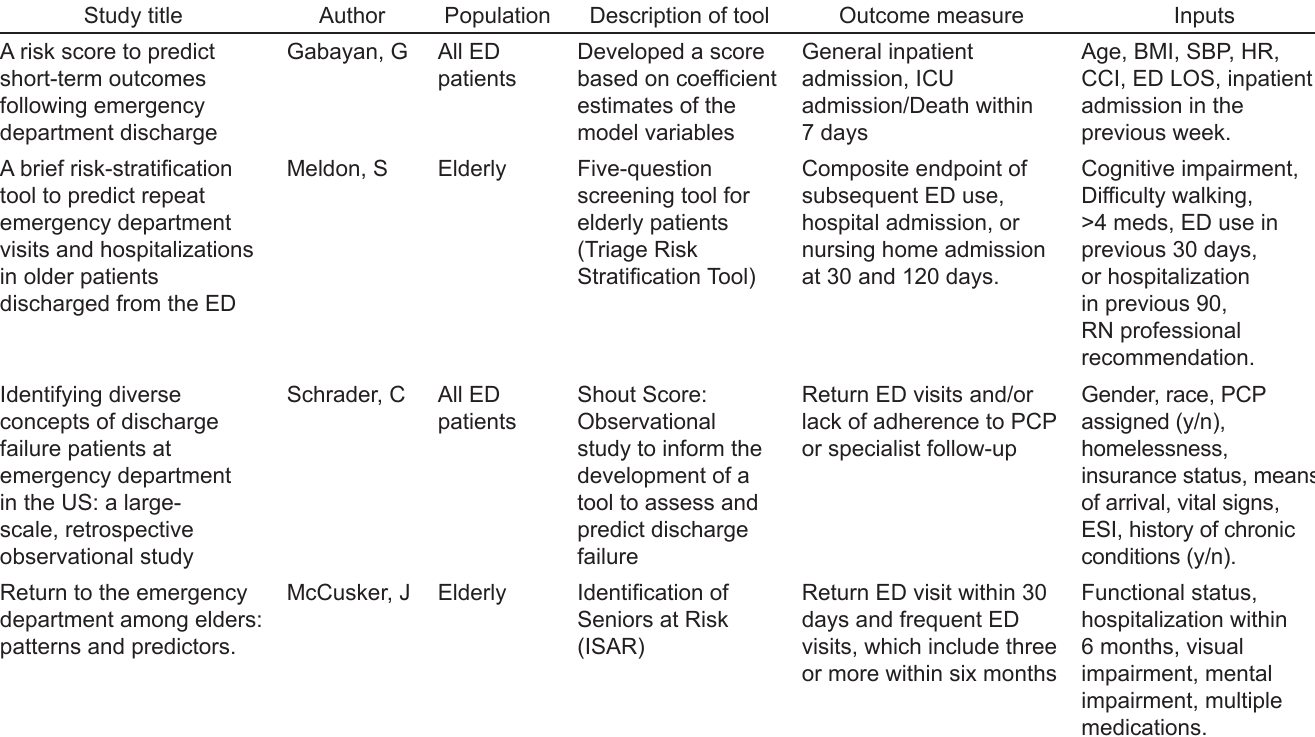
Table 1. Select point-of-care emergency department discharge risk assessment